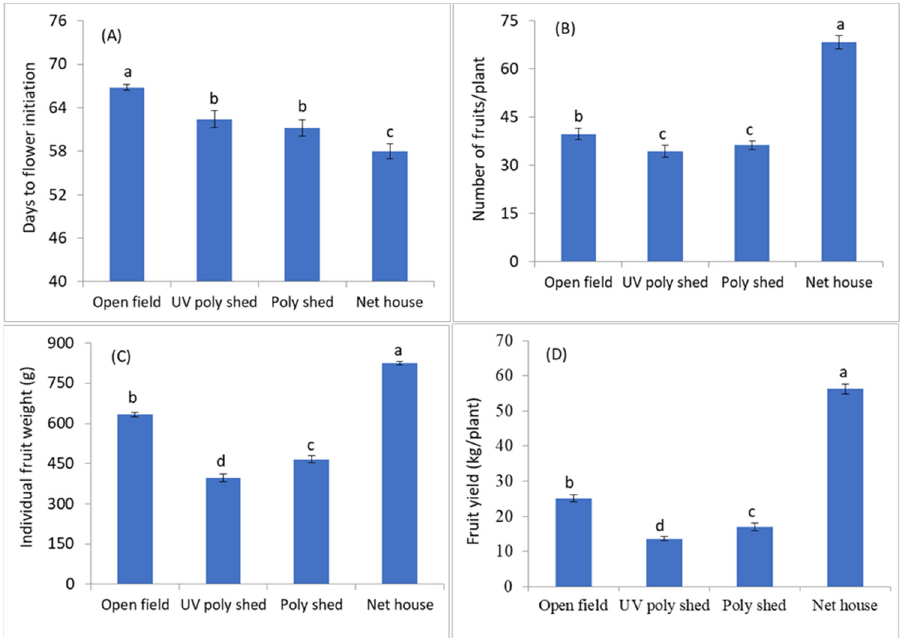
Figure 3. Average days to flower initiation ( A ), number of fruits/plant ( B ), individual fruit weight (g) ( C ) and fruit yield (kg) ( D ) of papaya grown under different sheds and open field condition. Mean ± s.e. (n = 15). Means with the same letter are not significantly different at p = 0.05 by Duncan’s multiple range test.